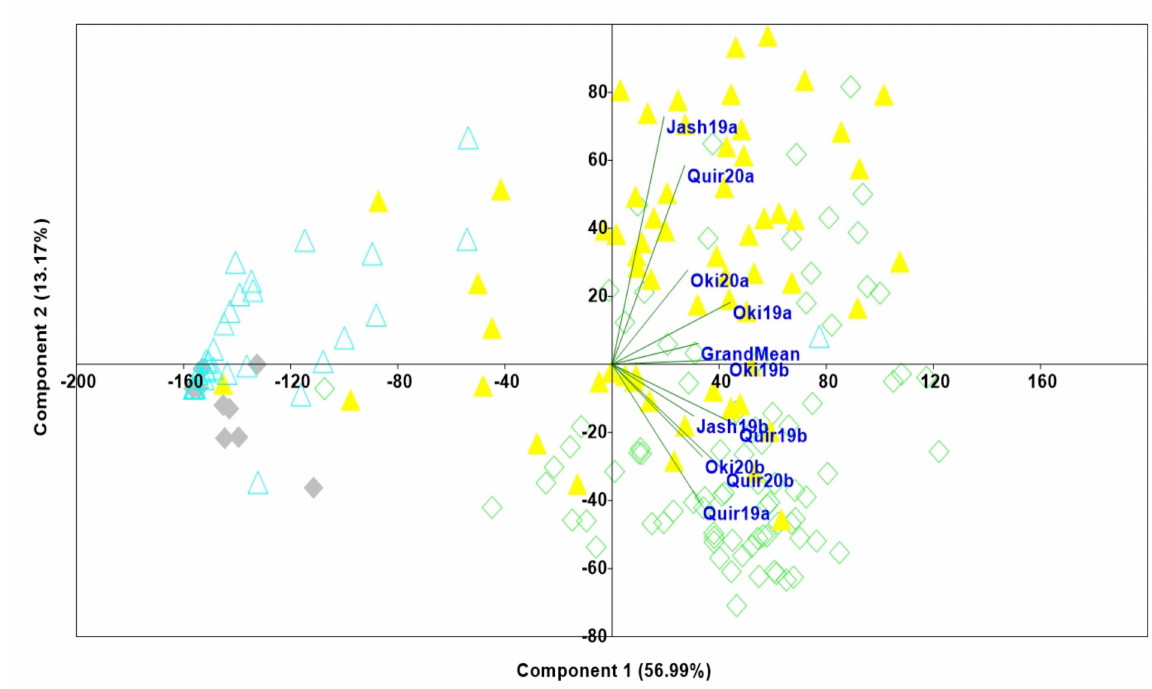
Figure 1. Principle component analysis of 187 wheat lines for blast index in all the environments. The genotypes of Indian and Bangladesh origin are depicted in triangle and diamond shapes, respectively. Genotypes with blue colored unfilled triangle and grey colored filled diamond are 2NS positive from India and Bangladesh,